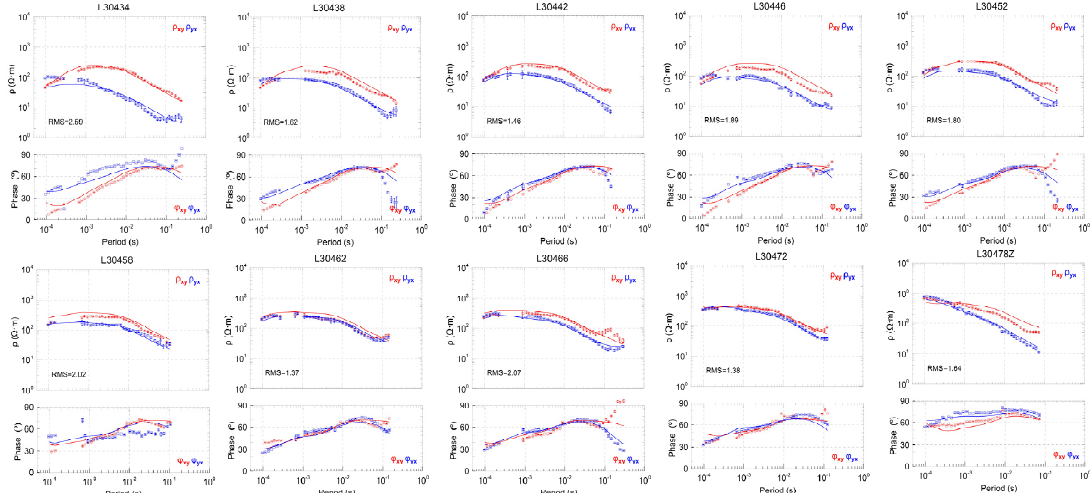
Figure A1. Observed and model response curves of apparent resistivity and phase data for the 2D inversion. The solid curves denote model responses. Small “T” signs emerging form dots on graph represent error bars.